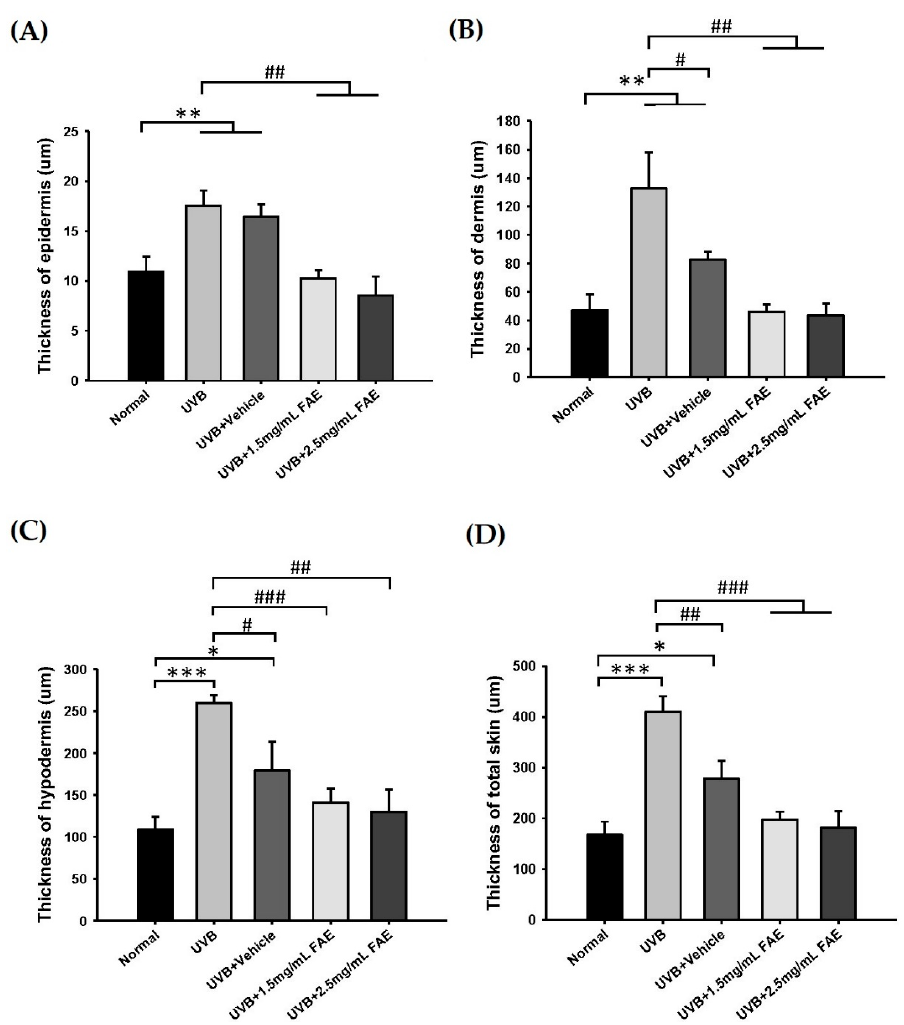
Figure 8. Quantification thickness of dorsal skin of BALB/c nude mice upon Ficus awkeotsang Makino extract (FAE) treatment at different concentrations following UVB irradiation for 10 weeks. ( A ) Thickness of epidermis, ( B ) thickness of dermis, ( C ) thickness of hypodermis, and ( D ) thickness of total skin. Statistically significant differences from the control were observed with: * p < 0.05, ** p < 0.01, *** p < 0.001; statistically significant difference from the UVB-exposure group was observed with: # p < 0.05, ## p < 0.01, ### p < 0.001 statistical significance was determined using the Tukey’s HSD test. n = 3; all error bars represent the standard deviation of the mean.